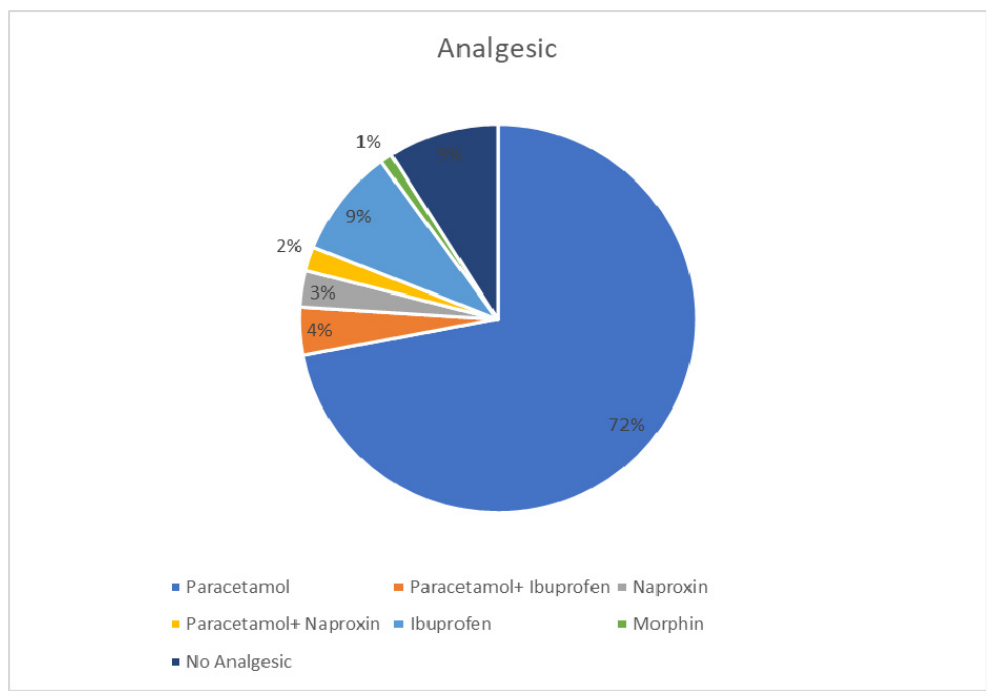
Figure 6. Usage of